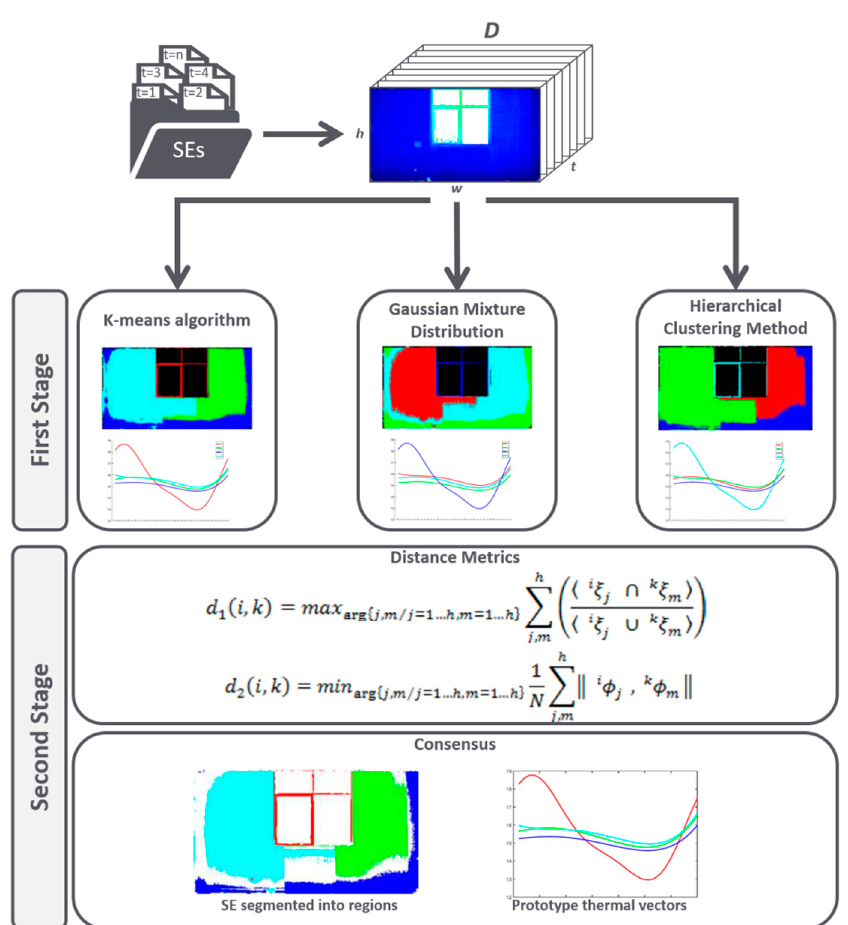
Figure 8. Flowchart of the automatic region segmentation through a temporal analysis of the thermal maps.